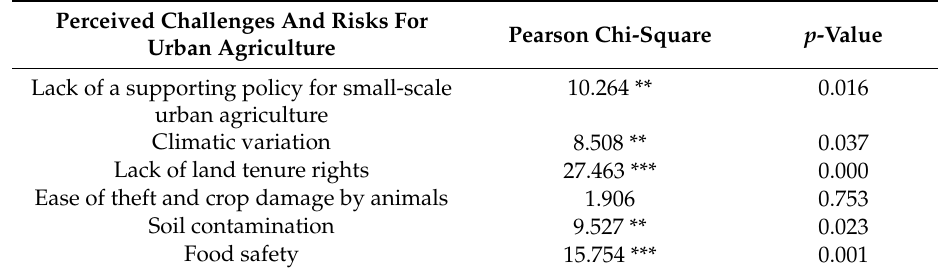
Table 7. The relationship between the perceived challenges and risks for urban farming and the utilisation of organic waste through urban agriculture in the Durban South Basin (n =